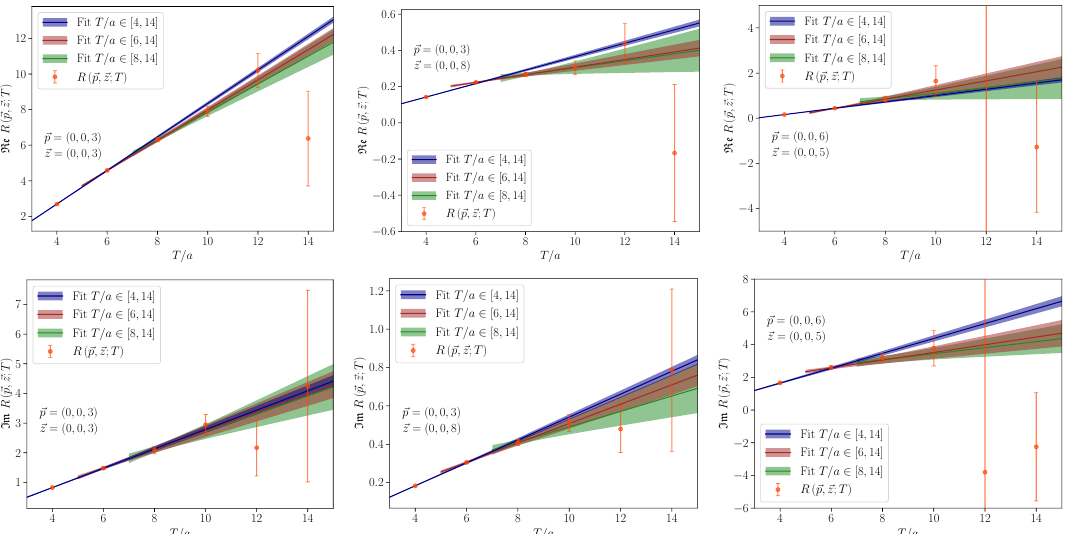
Figure 2 . Real (upper row) and imaginary (lower row) components of the summed ratio R ( ~p,~z ; T ) for select lattice momenta ~p together with the linear fit eq. 3.7 applied for varying temporal series. The length of the Wilson line is increased from left to right for each momentum, and given in integer multiples of the lattice spacing. Each panel corresponds to R ( ~p,~z ; T ) determined from a particular subduced correlation function, which are discussed in section 3.3.